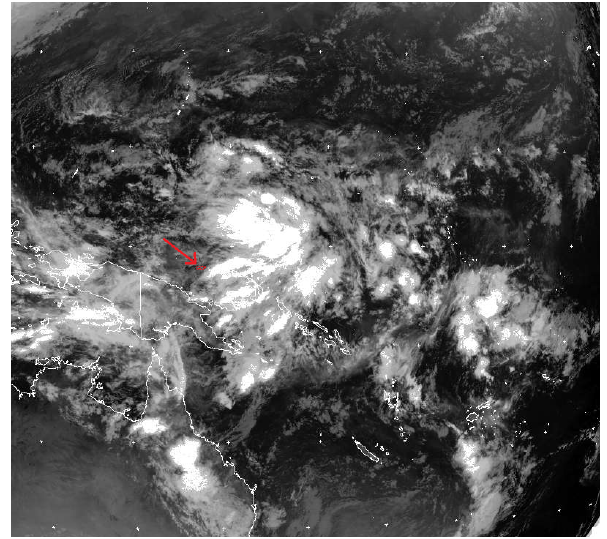
Figure 8. MTSAT channel 2 (near-infrared) image from 19 Febru- ary 2014, 18:00UTC. The convection to the east of Manus Island (red arrow) is visible as the brightest clouds in the image.